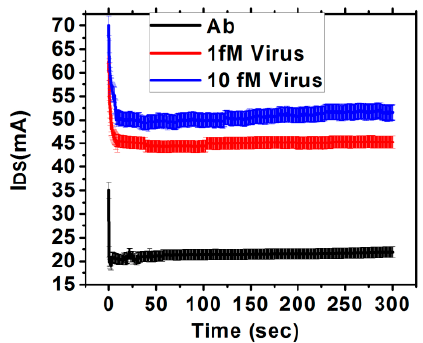
Figure 6. Variation of I DS with time after antibody binding and with increasing concentration of Hep-B virus.